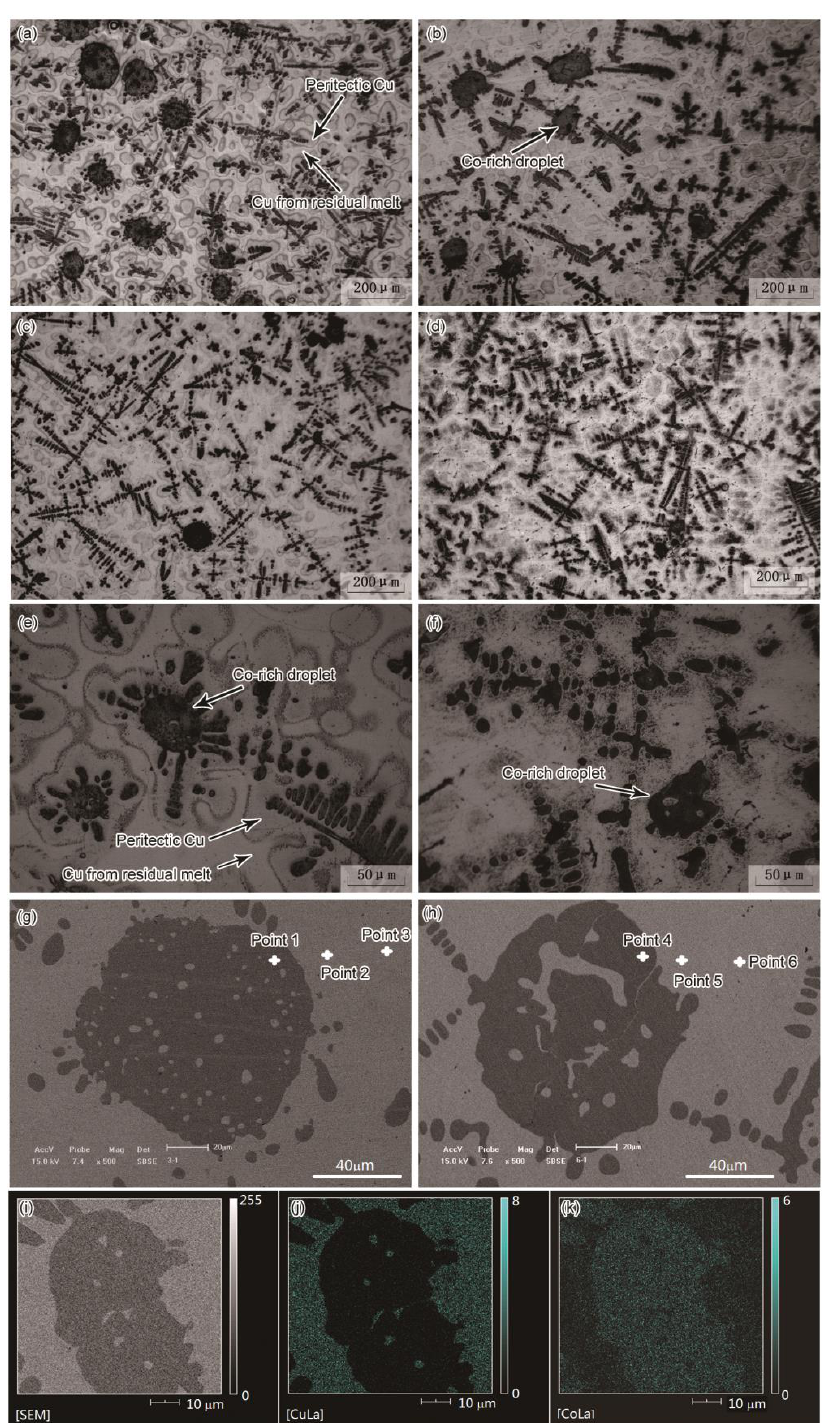
Figure 2. Microstructure of the Cu-Co ingot solidified without EMS ( a ), with EMS by setting current intensity at 100 A ( b ), 200 A ( c ) and 300 A ( d ); A higher magnification of microstructure without EMS ( e ), with EMS of 300 A ( f ). The internal structure of Co-rich droplets without EMS ( g ) and with EMS of 300 A current ( h ) respectively; The scanning electron microscopy (SEM) image of a droplet in the ingot without EMS ( i ), and the results of energy-dispersive X-ray spectroscopy (EDS) mapping of element Cu ( j ) and Co ( k ) respectively.